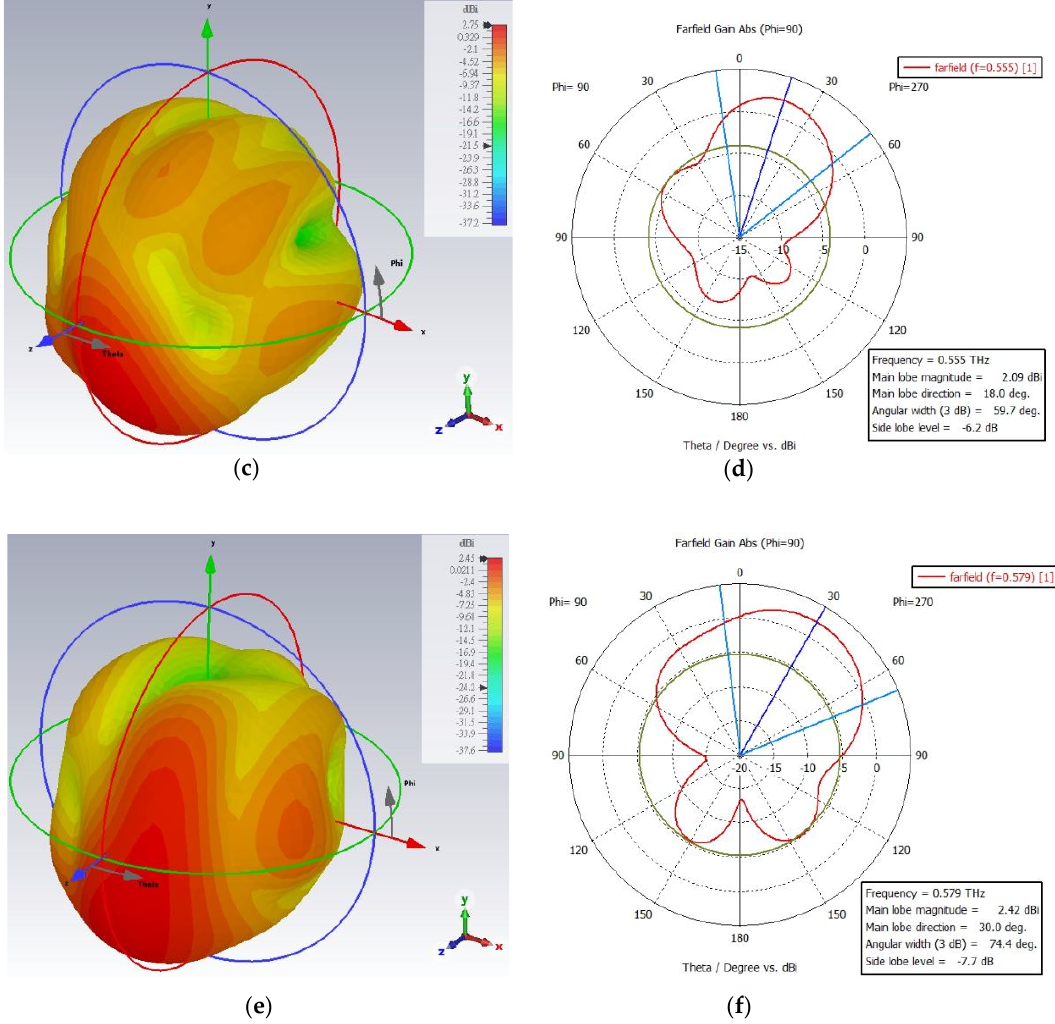
Figure 9. The 3D and polar plot of the farfield gain of different electrical length two segment Hilbert fractal reconfigurable antenna in ordinary polarization in the PDLC. ( a , b ) Two segments with no cut (at 0.558 THz), ( c , d ) two segments with cut (large electrical length) left shift (at 0.555 THz), and ( e , f ) with cut (small electrical length) right shift (at 0.579 THz) of the fractal